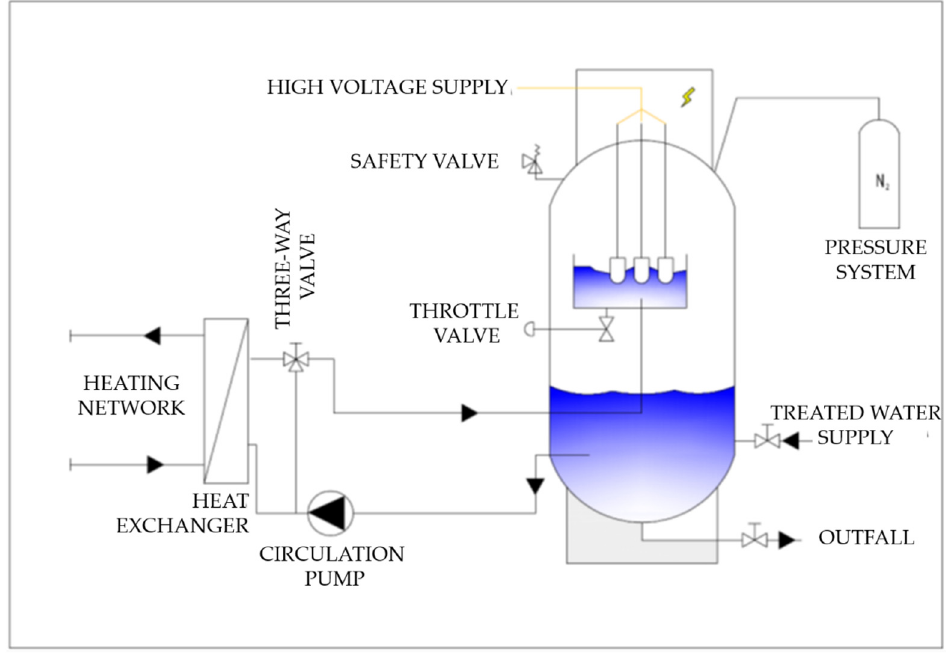
Figure 12. Scheme of the electrode boiler. Example of an installed 10 MW electrode boiler from Parat in Denmark is presented in Figure